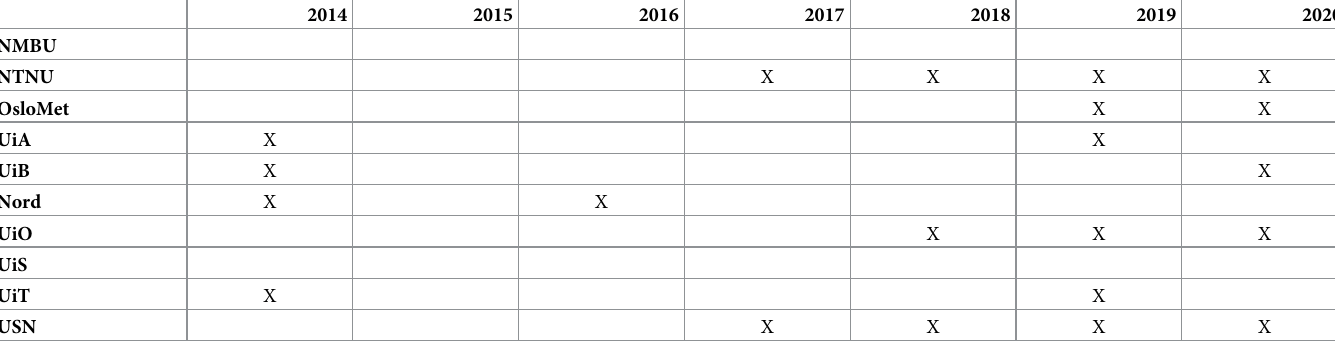
Table 2. Timeline of annual reports. Marked cells signify whether the report incorporates any numbers on the growth and prevalence of open